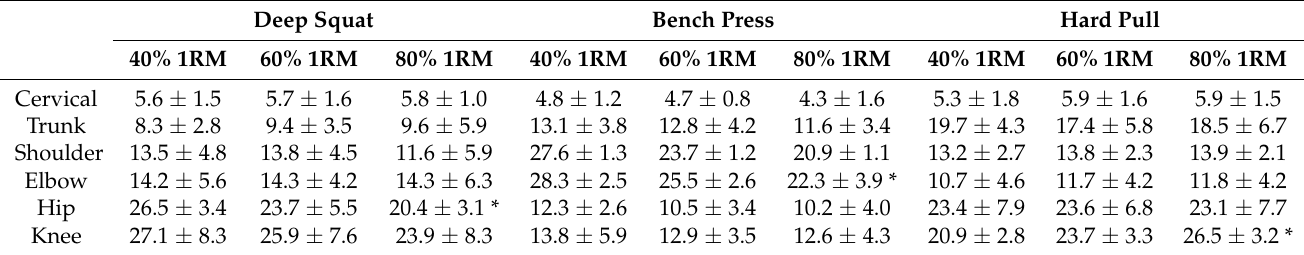
Table 5. Comparisons of peak torques in different load strength tests